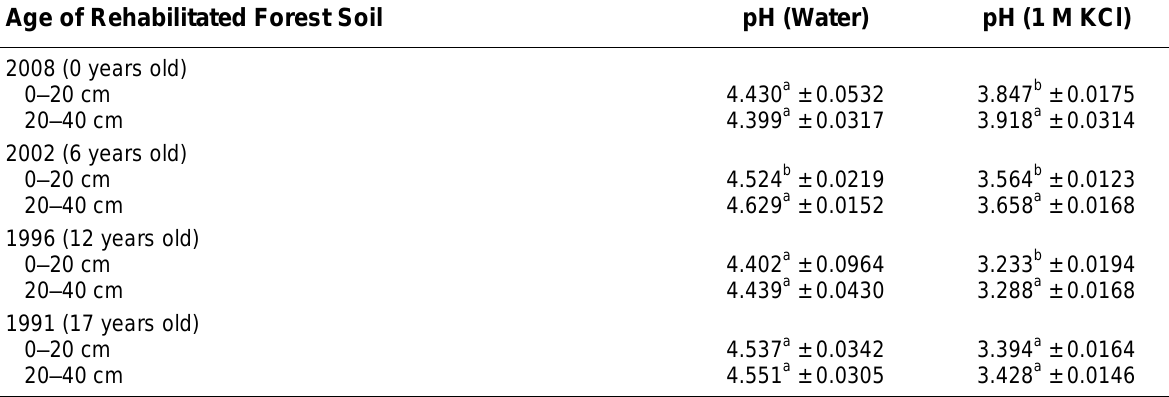
pH of a Rehabilitated Forest Soil (between Depths) Age of Rehabilitated Forest Soil